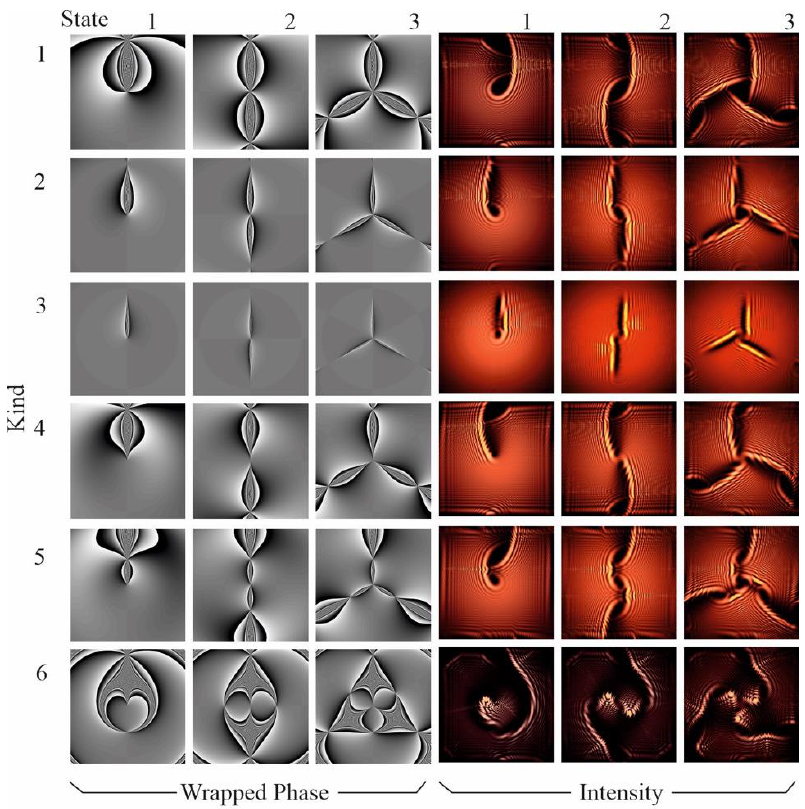
Figure 2. Columns 1 to 3: examples of phase patterns for the generation of singular beams. Each Kind is evaluated for states ℓ = 1 to ℓ = 3 . Columns 4 to 6: intensity profiles as generated from the phase patterns in columns 1 to 3, for a propagation of 62 cm. Each Kind is evaluated for states (cid:96) = 1 to (cid:96) = 3.